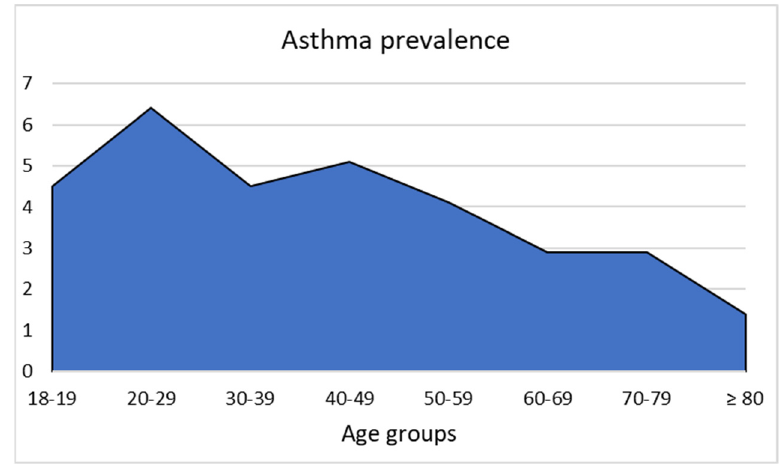
Figure 1. Asthma prevalence among the study participants, stratified by age groups.